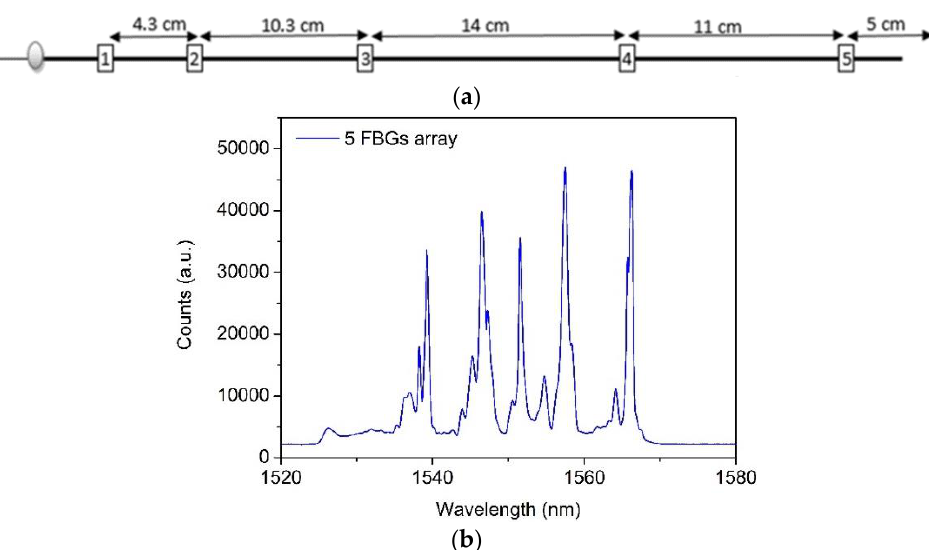
Figure 2. ( a ) Schematic demonstration of the physical distances between fiber Bragg gratings (FBGs) in the cyclic transparent amorphous fluoropolymers (CYTOP) fiber. ( b ) Reflected optical spectrum of the five-sensors FBG array inscribed in 120 µm core diameter, multimode, gradient index CYTOP fiber when illuminated with broadband light source and measured using a commercial FBG spectrometer.